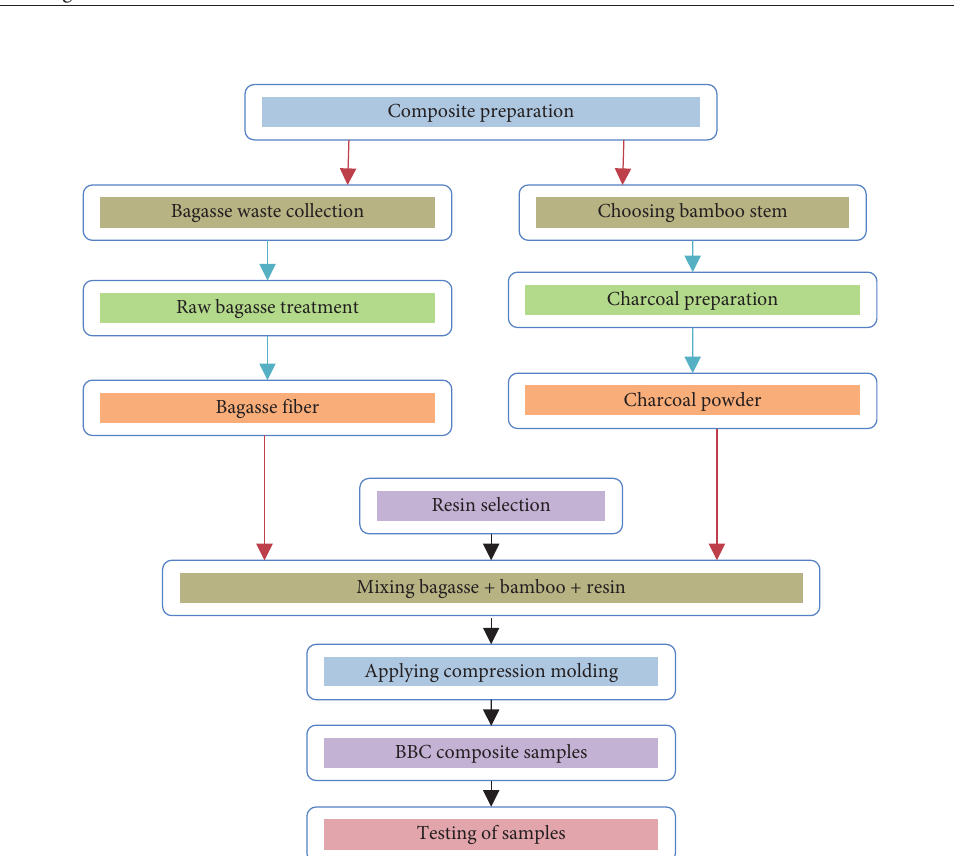
Figure 3: Composite fabrication